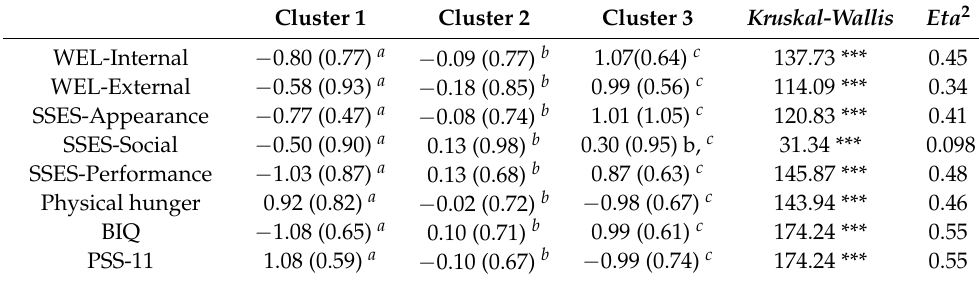
Table 4. Mean comparisons on the standardized clustering variables used in the male